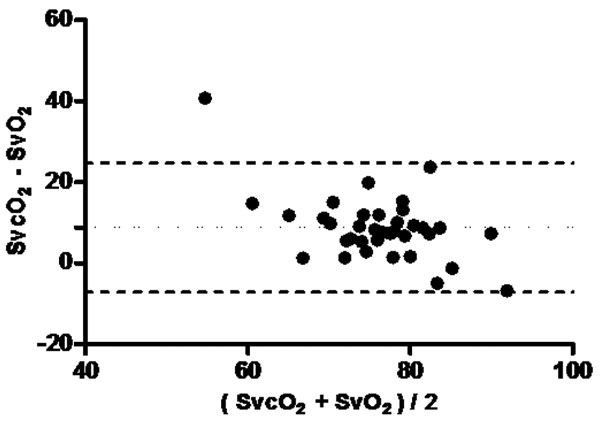
Bland-Altman (SvO2×SvcO2) in Group 1: bias 8.778, bias SD 8.137. 95% Limits of agreement: -7.171 to 24.73.